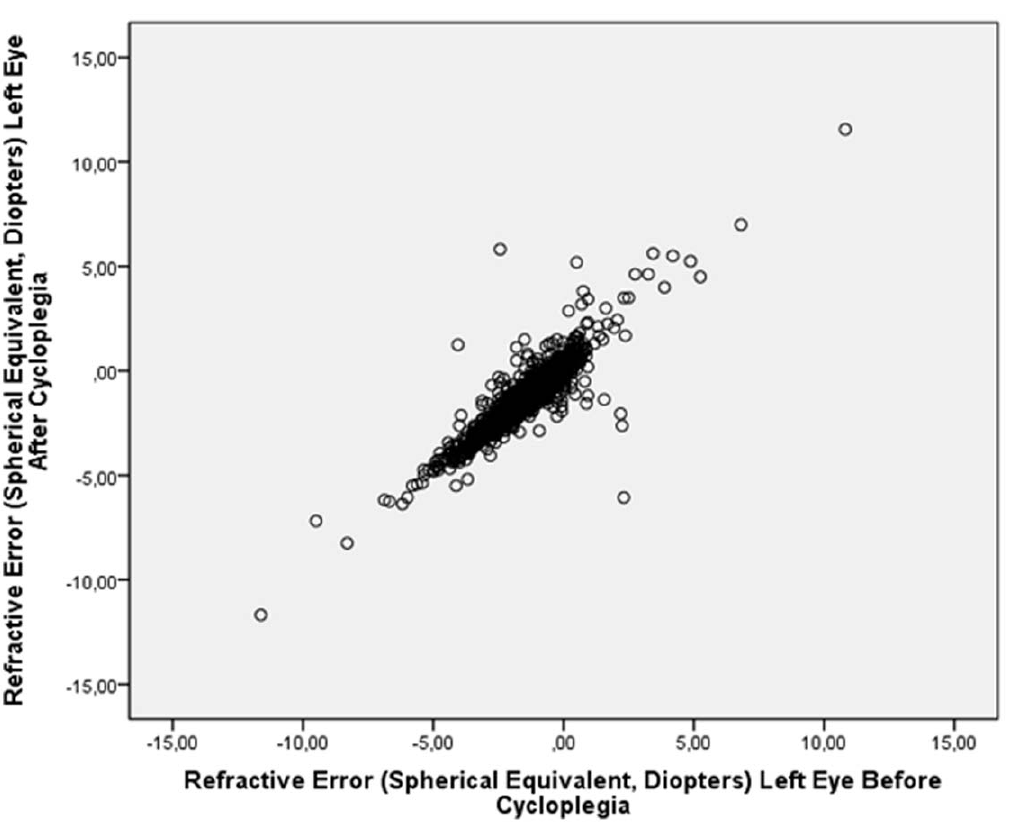
Figure 1. Scattergram showing the distribution of refractive error before and after cycloplegia in 1082 children with a mean age of 10.4 ± 2.3 years.